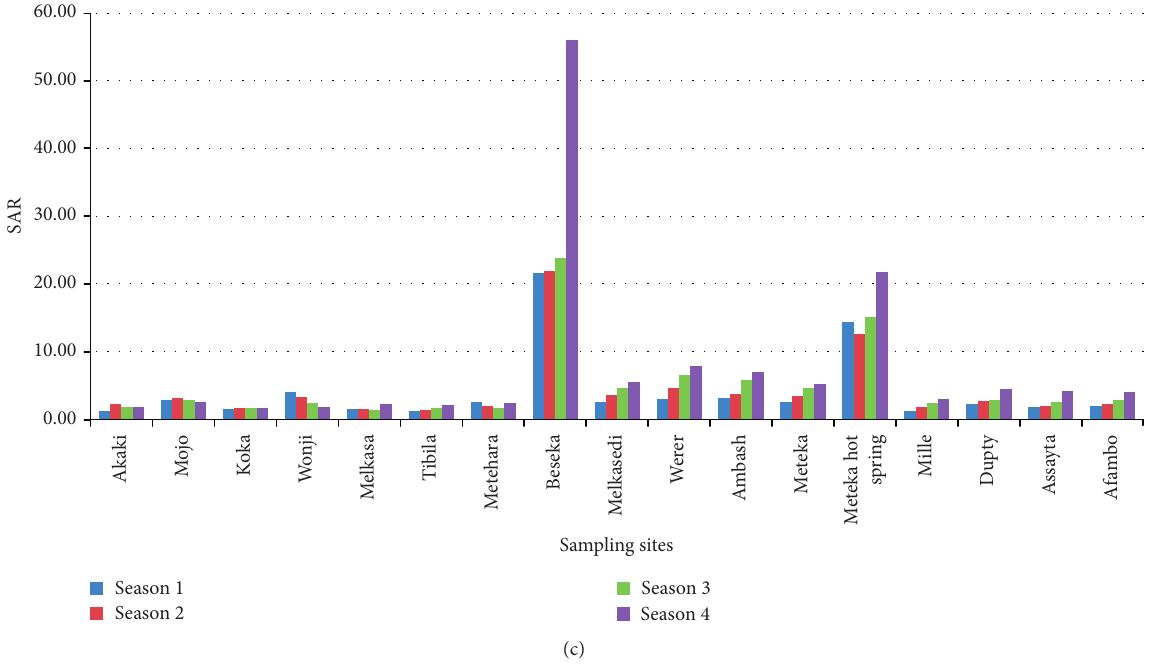
Figure 2: Mean seasonal variation of pH across different locations over years